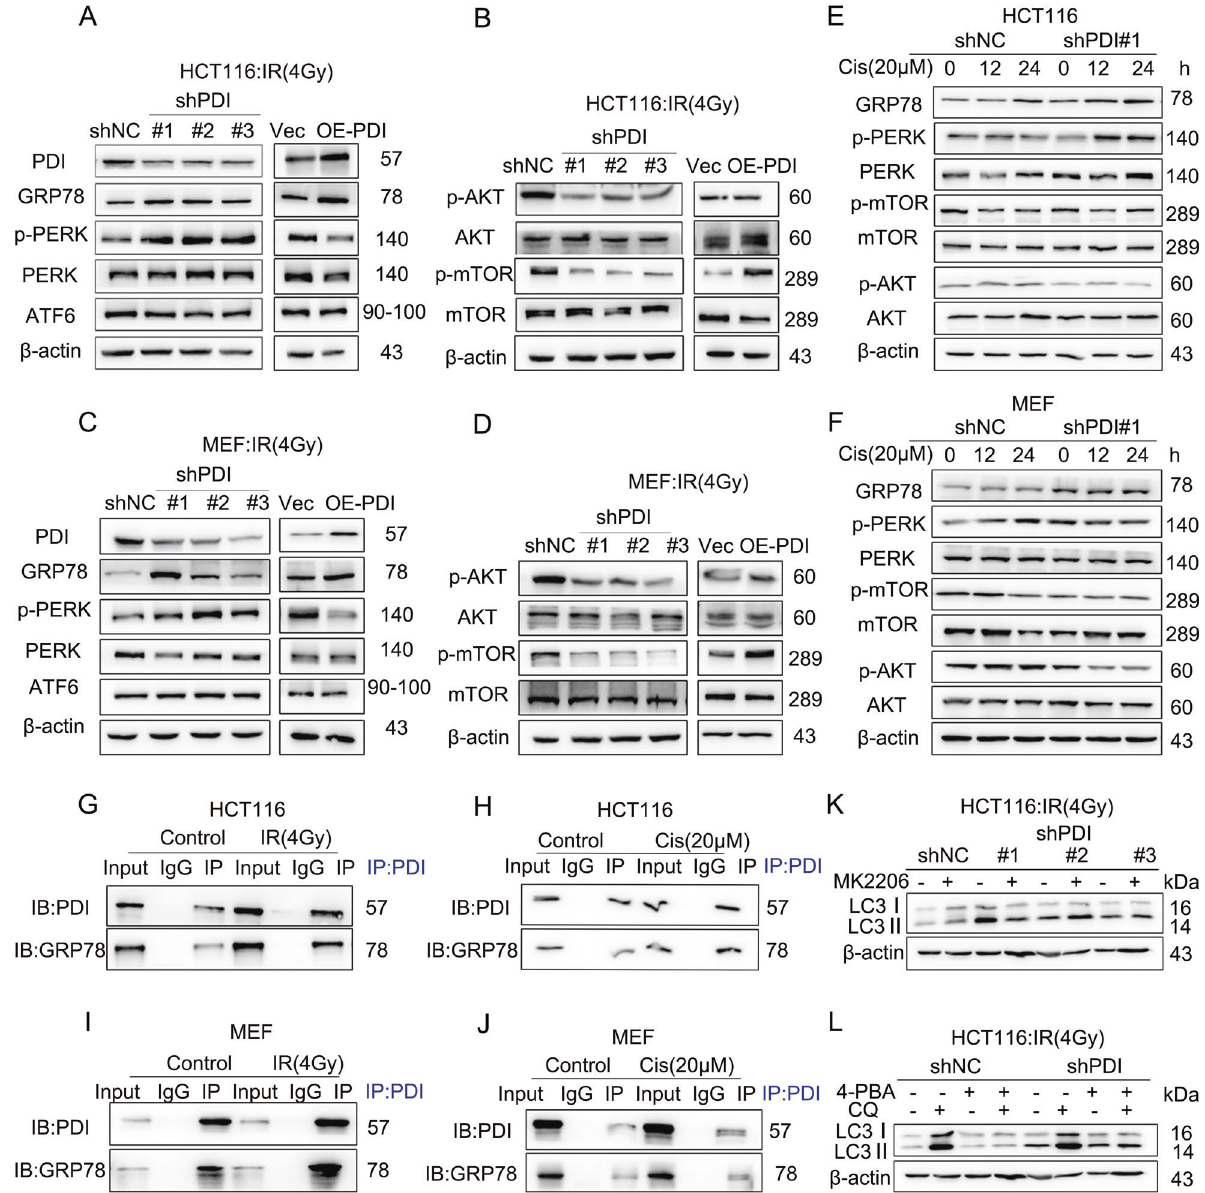
HCT116 or MEF cells treated with γ -ray (4 Gy) or cisplatin (20 μ M) irradiation for 24 h. E , F Immunoblot analysis showing the levels of ERS pathway-related proteins and AKT/mTOR pathway-related proteins in PDI knockdown or overexpression MEF cells treated with γ -ray irradiation ( E ) or cisplatin ( F ) for 24 h. G , H The existence of PDI in the co-precipitated complexes was con fi rmed by western blotting, IgG was employed as the negative control. Western blotting shows the association of PDI with GRP78 after Co-IP in HCT116 cells were treated with γ